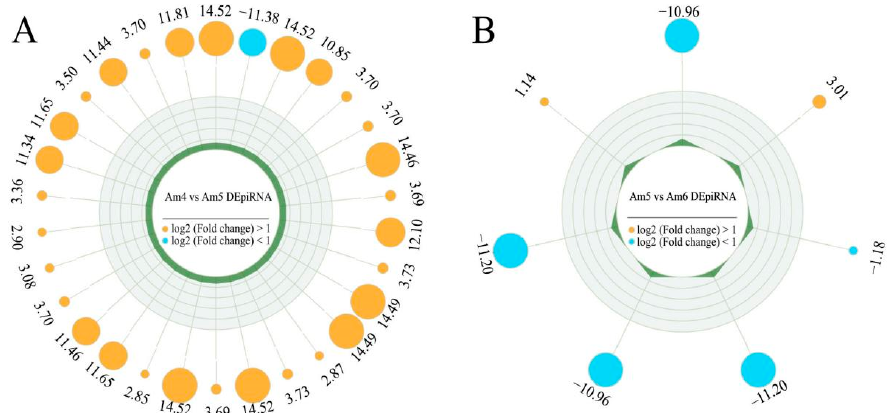
Figure 2. Radar maps of DEpiRNAs. ( A ) A total of 30 DEpiRNAs among 78 DEpiRNAs in the “Am4 vs. Am5” comparison groups. ( B ) A total of seven DEpiRNAs in the “Am5 vs. Am6” comparison groups.